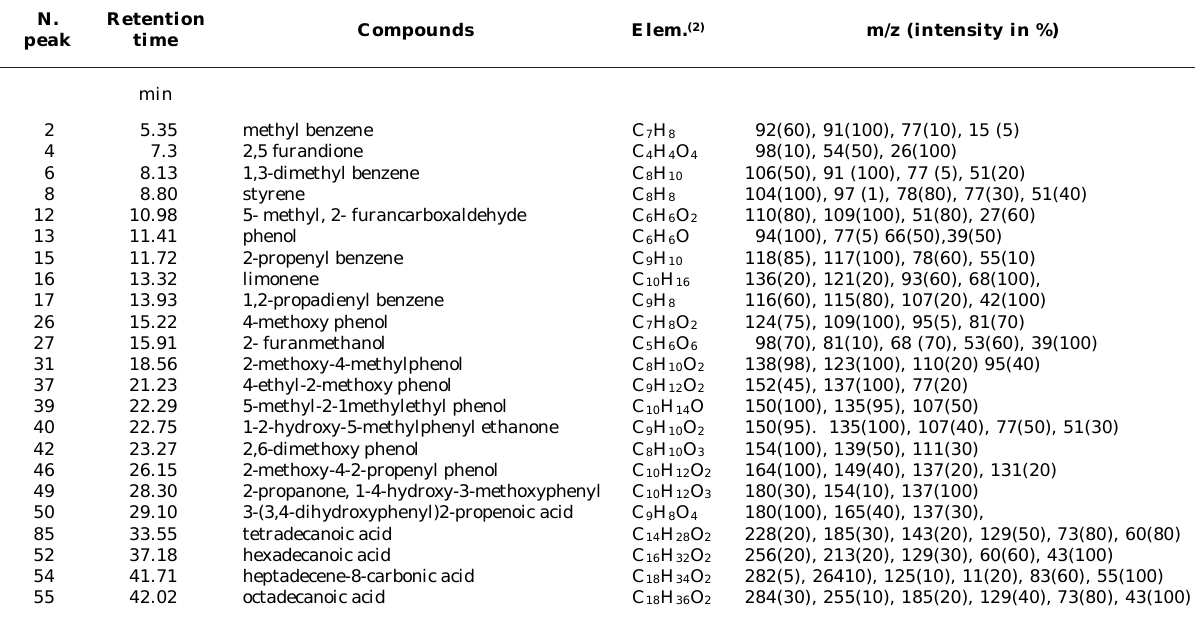
(1) Only those peaks with a similarity above 90% with the Nist library and consistent fragmentation pathway. (2) Elemental composition.